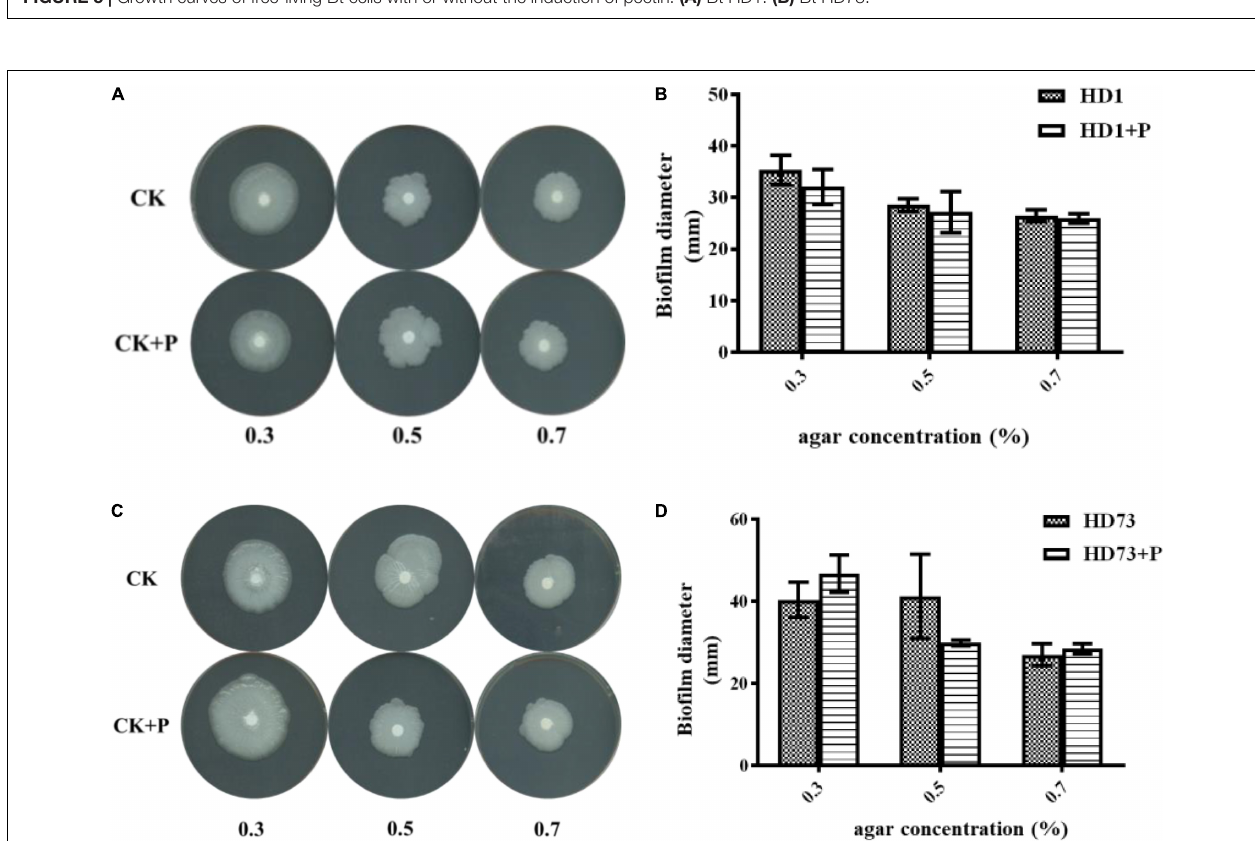
FIGURE 6 | Effects of pectin on the cell motility of Bt strains HD1 and HD73. (A,B) HD1. (C,D) HD73.